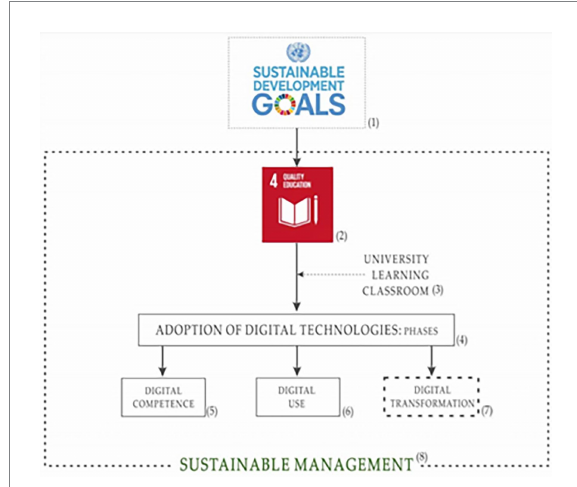
FIGURE 1 Sustainability development model (Abad-Segura et al., 2020).